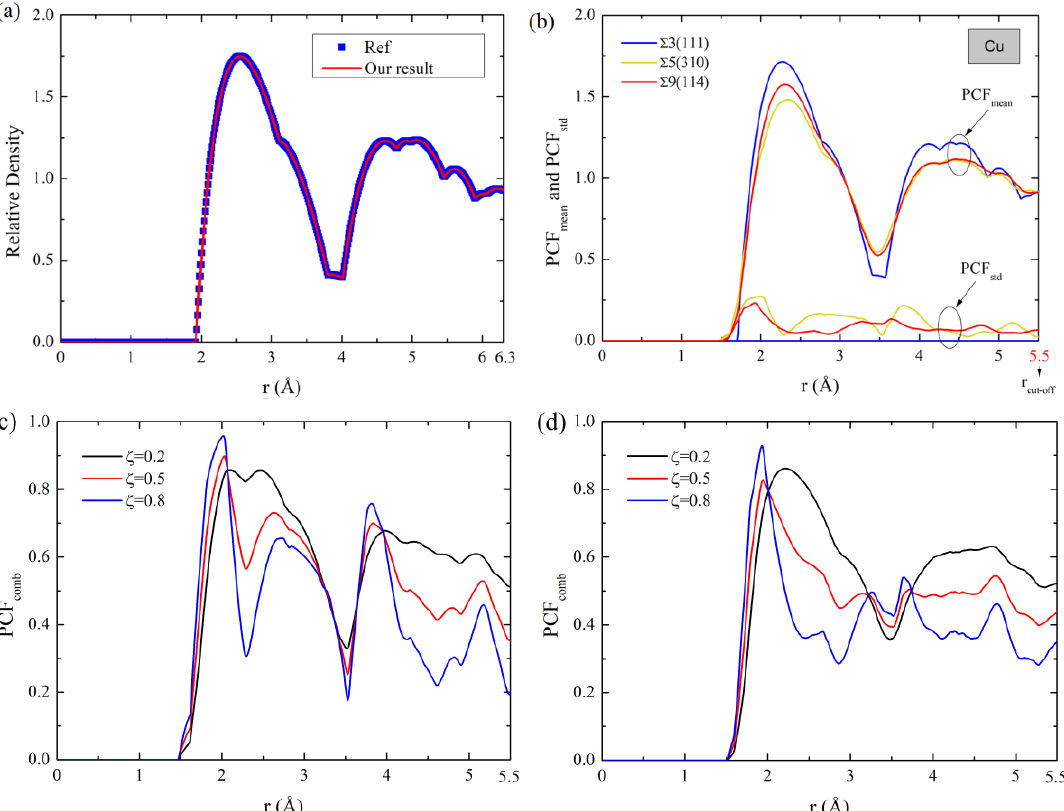
Figure 1. ( a ) PCF of Al single crystal compared with the results taken from [16], ( b ) PCF mean and PCF std (r) of Cu GBs ∑ 5(310), ∑ 9(114) and ∑ 3(111). PCF comb (r) of Cu GBs ( c ) ∑ 5(310) and ( d ) ∑ 9(114) for ζ = 0.2, 0.5 and 0.8. Results of figure ( b ) for Al and Ni are shown in Figure S3 in Supplementary Material.